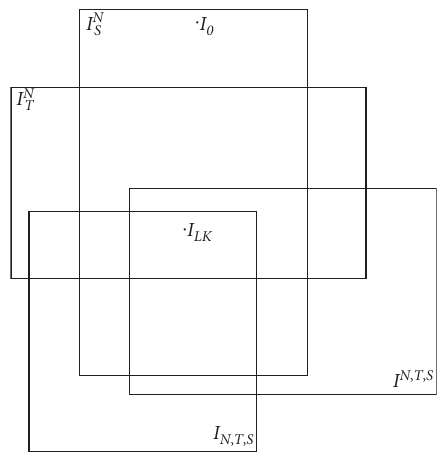
Figure 5: Sets of ( T,N ) -, D ′ -, QL ′ -, and R ′